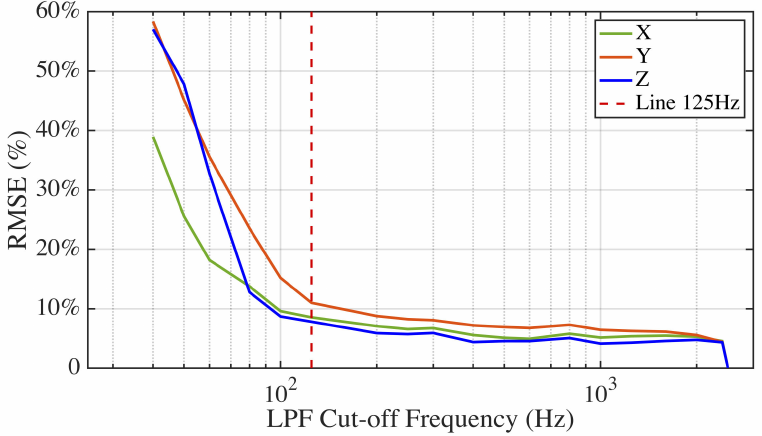
Figure 10. RMSE (%) between low-pass filtered signals and raw signals for a normalized stride as a function of LPF cut-off